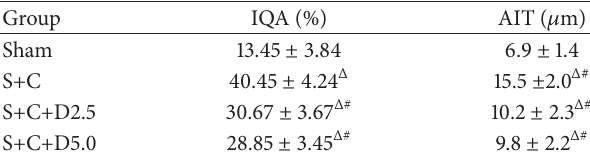
Table 4: The index of quantitative assessment of lung (IQA) and alveolar interval thickness